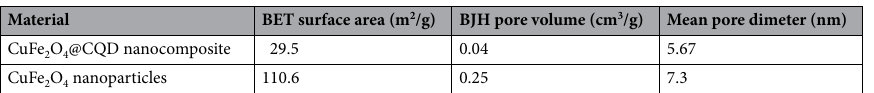
Table 1. Structural and textural properties of the prepared